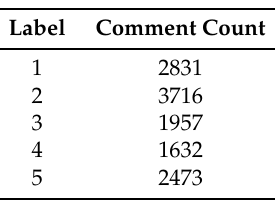
Table 2. Number of comments in each label category for the Marglish dataset.